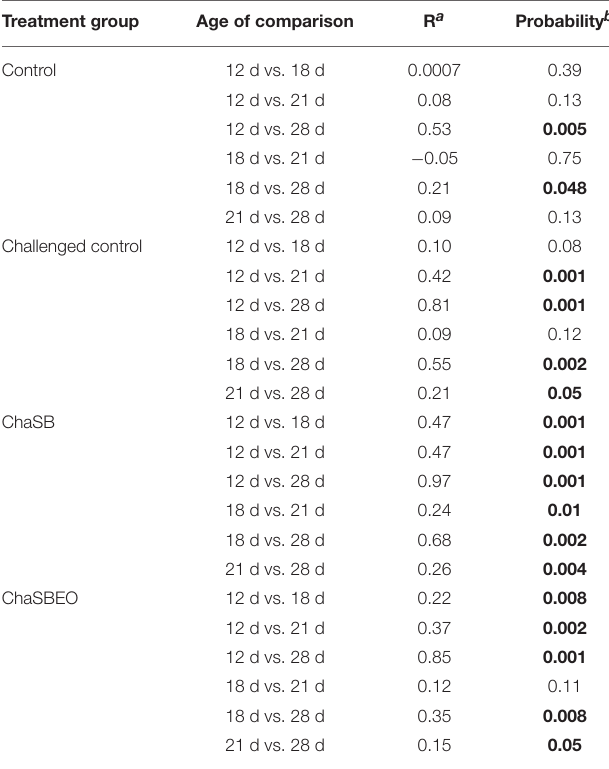
TABLE 4 | ANOSIM analysis results comparing the different timepoints within each of the treatment groups. Treatment